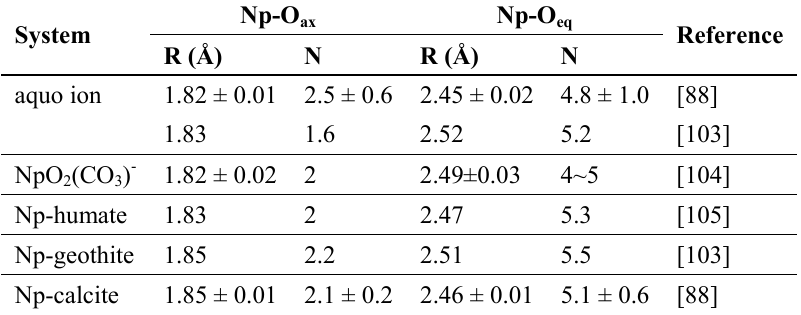
Table 4. Results of EXAFS data obtained for Np(V) aquo ions, Np(V) humate and Np(V) adsorbed to α -FeOOH and calcite.